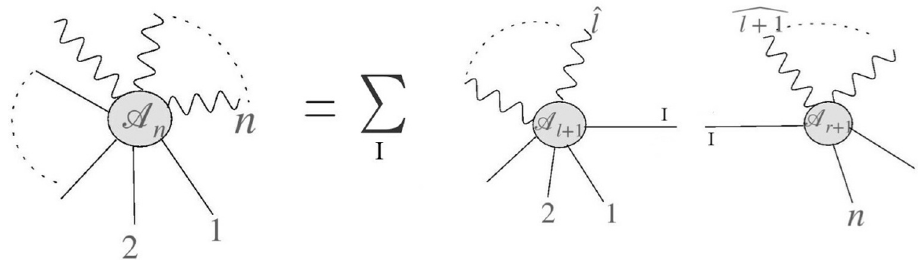
Figure 1 . BCFW recursion